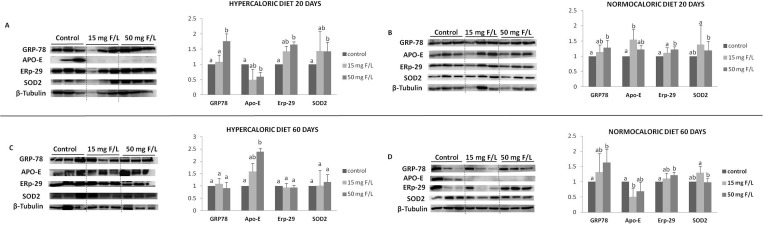
Representative expression of proteins GRP-78, APO-E, SOD2, ERP-29 and of the constitutive protein β-tubulin in samples of individual animals (n = 3) from each group.Densitometric analysis was performed for 6 animals per group. A. Protein expression in the liver of rats in the group treated with the hypercaloric diet for 20 days; B. Protein expression in the liver of rats treated with the normocaloric diet for 20 days; C. Protein expression in the liver of rats in in the group treated with the hypercaloric diet for 60 days; D. Protein expression in the liver of rats treated with the normocaloric diet for 60 days. Densitometry was analyzed using the software Image Studio Lite. Vertical bars represent standard deviations. For each condition, distinct superscripts denote significant differences among the groups (ANOVA and Tukey’s test, p<0.05, n = 6).